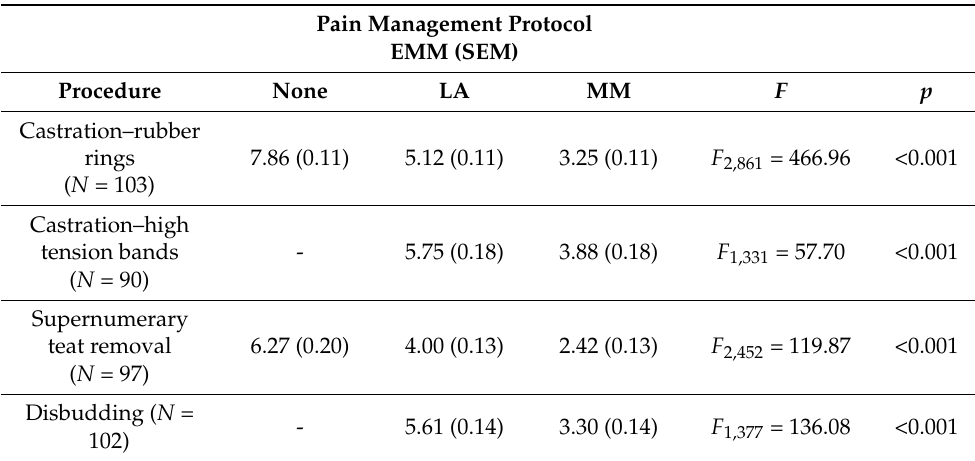
Table 4. Estimated marginal means (EMM) and standard error of the means (SEM) for the perceived pain scores a of veterinarians across certain husbandry procedures by pain management protocol: none, local anaesthetic only (LA), or multimodal (MM) b , with demographic variables modelled as fixed effects c